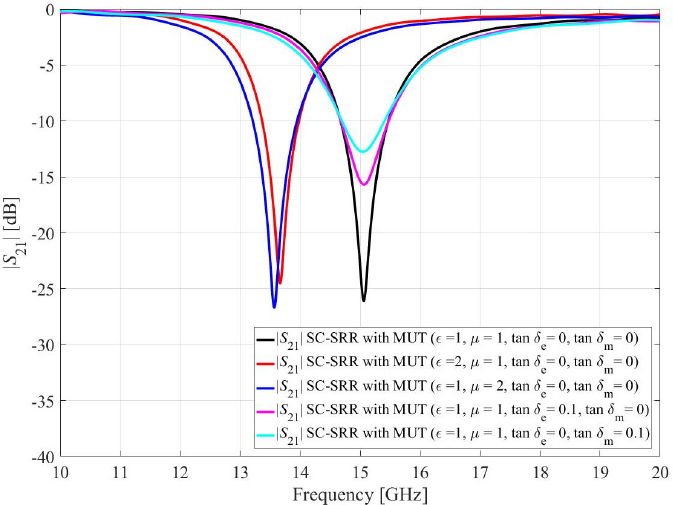
Figure 8. Simulated transmission coefficients ( S 21 ) of the SC ‐ SRR due to interaction with the sample under test (SUT) by perturbing one of SUT’s electromagnetic parameters.